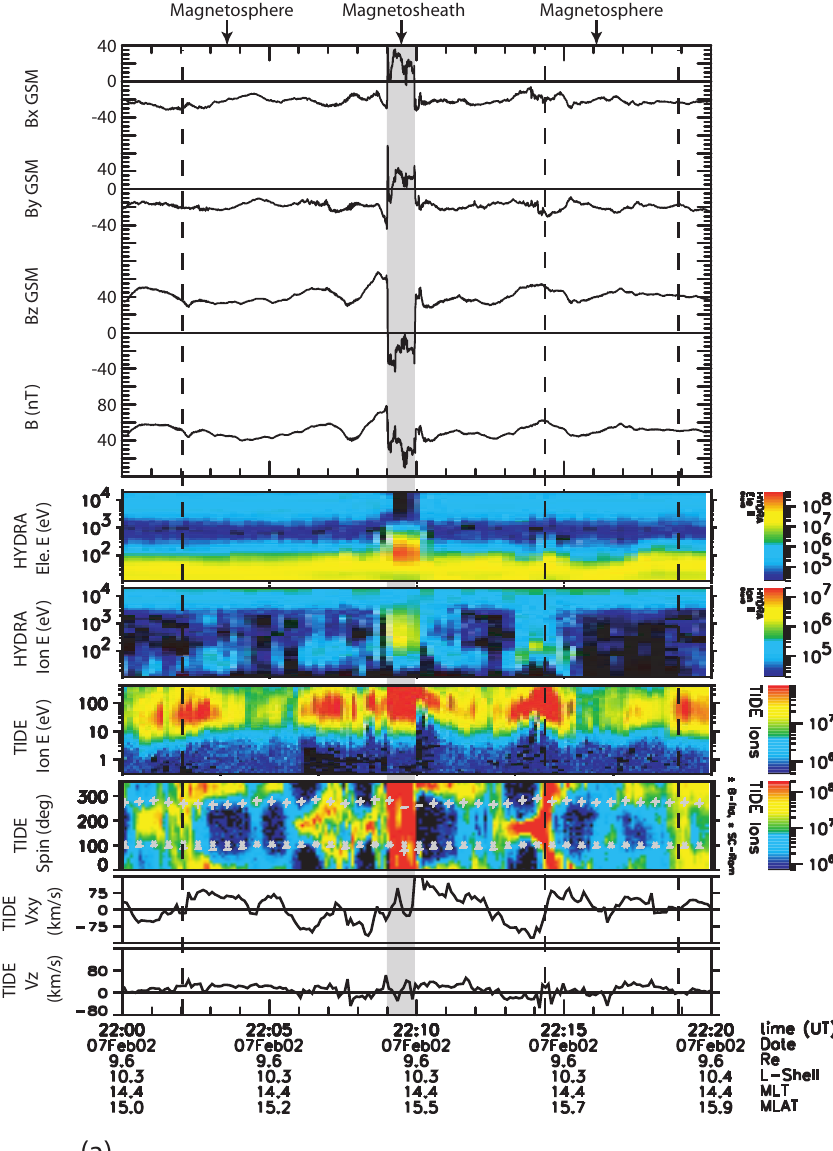
Fig. 5. Magnetopause crossings during the intervals ( a ) 22:00–22:20 UT and ( b ) 23:10–23:30 UT. Shown, from top to bottom, are the highest time resolution (8 samples/s) magnetic field data, the HYDRA ion and electron energy spectrograms, the TIDE ion energy and spin angle spectrograms, and the TIDE ion velocity moment data. The ion velocity components V xy and V z shown in the bottom panels are the spin plane velocity projected to the equatorial plane (nearly aligned to the radial direction) and along the Z-axis (north), respectively.